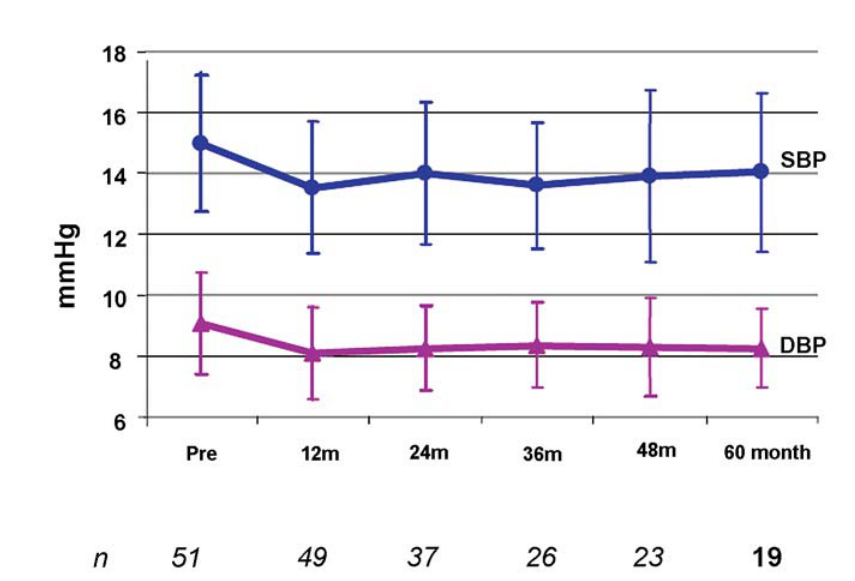
Figure 1 – Average SBP and DBP pre - and post-nephrectomy in patients with